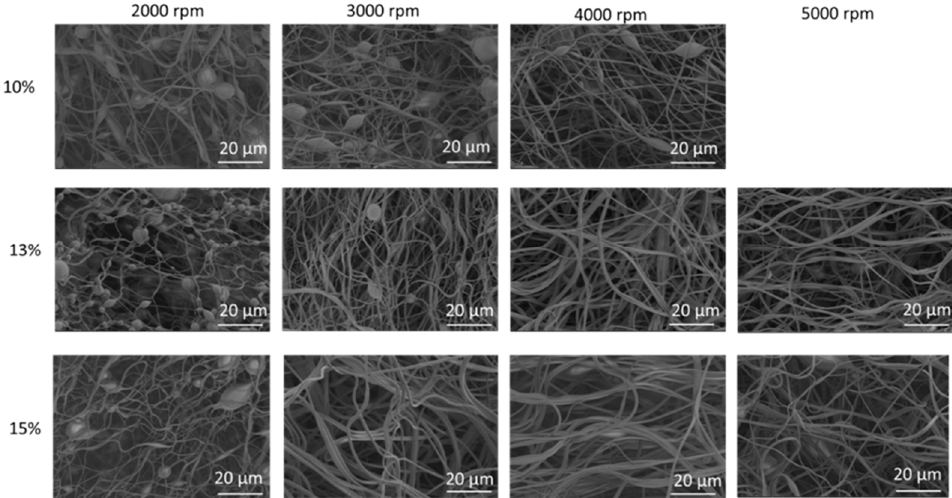
Figure 2. SEM images of PVA nanofibers fabricated with different solution concentrations and rotation speeds.